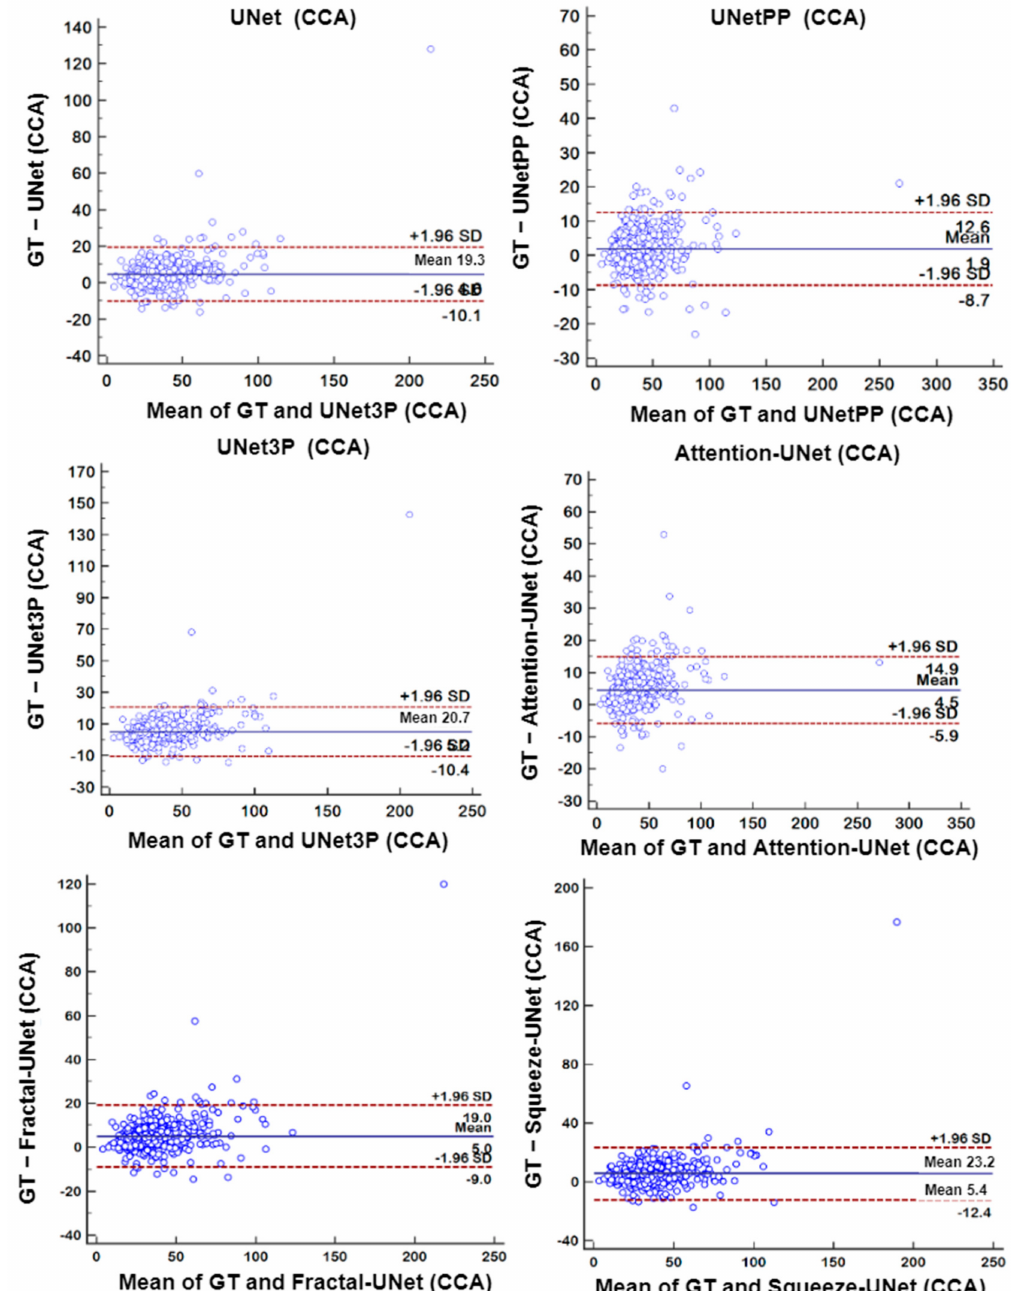
Figure 17. Bland–Altman Plot of all 6 types of models for CCA DB2A